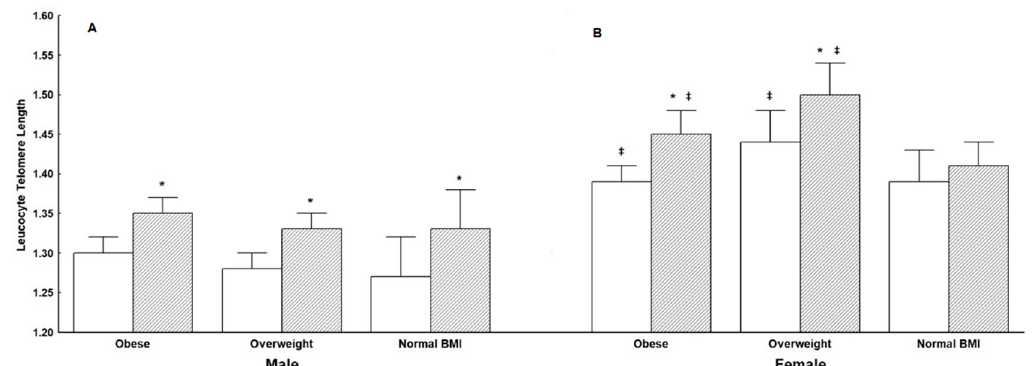
Figure 2. ( A ) Leukocyte telomere length (LTL) (mean ± SE) of male and female subjects with “good compliance” ( n = 407), who were grouped as obese, overweight, or of normal-BMI at initial assessment (white bars) and same participants at 12 months (shaded bars). Panel ( B ): leukocyte telomere length (LTL) of male and female, prepubertal, and pubertal who were grouped as obese, overweight, or of normal-BMI at initial assessment (white bars) and at 12 months (shaded bars). All measured variables were compared by employing repeated-measures ANOVA. Significant main effects were revealed by the LSD posthoc test. Statistical significance was set at ( p < 0.05). * Indicates significant difference between initial assessment and 12 months follow-up, time-points; ‡ Indicates signi fi cant di ff erence from the Male group.